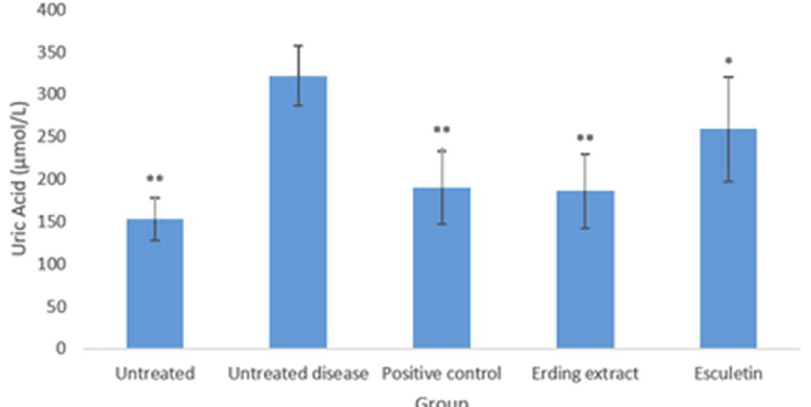
FIGURE 3 - Effects of esculetin and the Erding extract on the serum UA levels in mice with potassium oxonate-induced hyperuricemia. *p-value<0.05 and **p-value <0.01 compared with the untreated disease